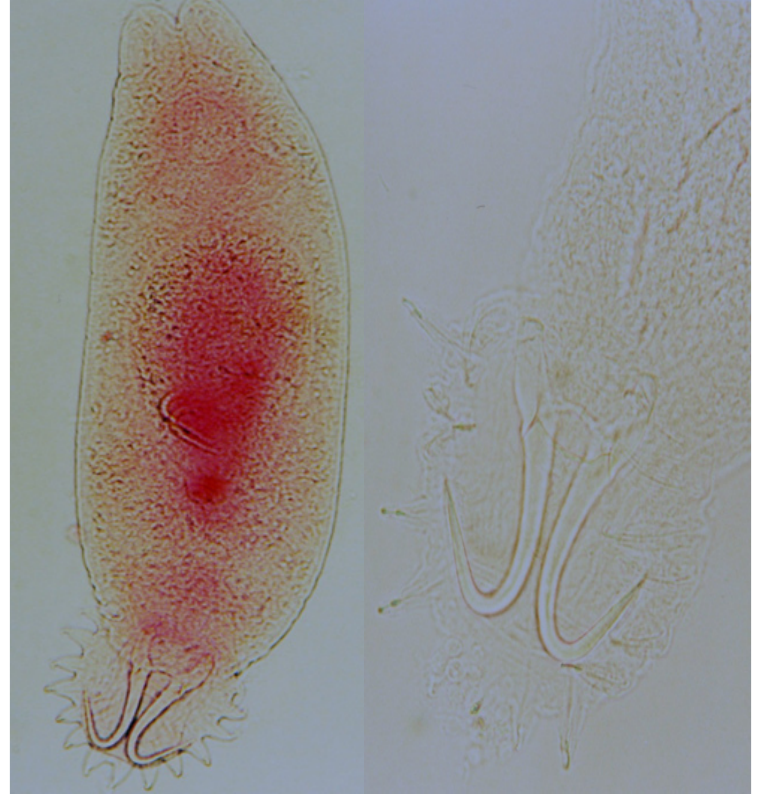
Fig. 1. G. katharineri total view and haptor part (original)